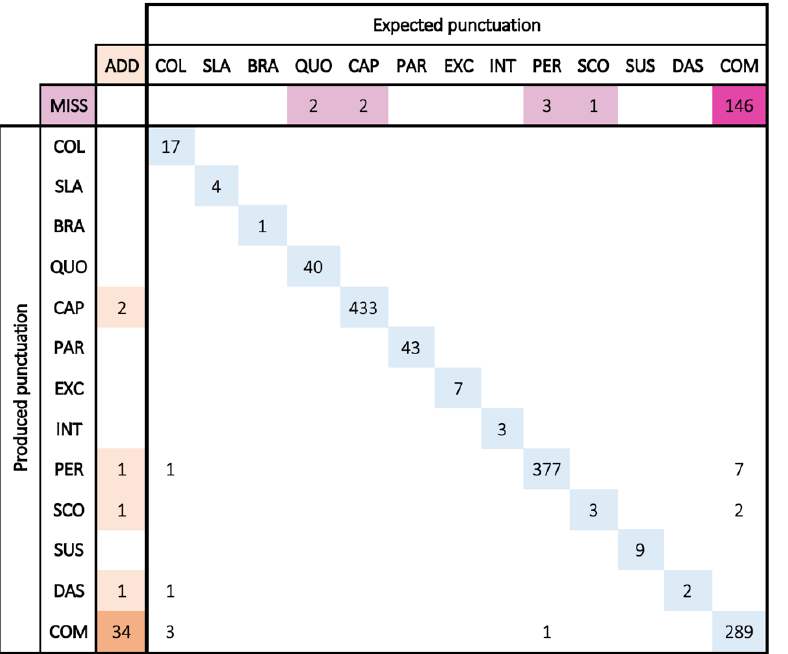
Figure 1. Control group confusion matrix: in the rows, how much each symbol was produced (or missed); in the columns, how many times it was expected (or added) (see Section 5.2.1 for interpretation guidelines).